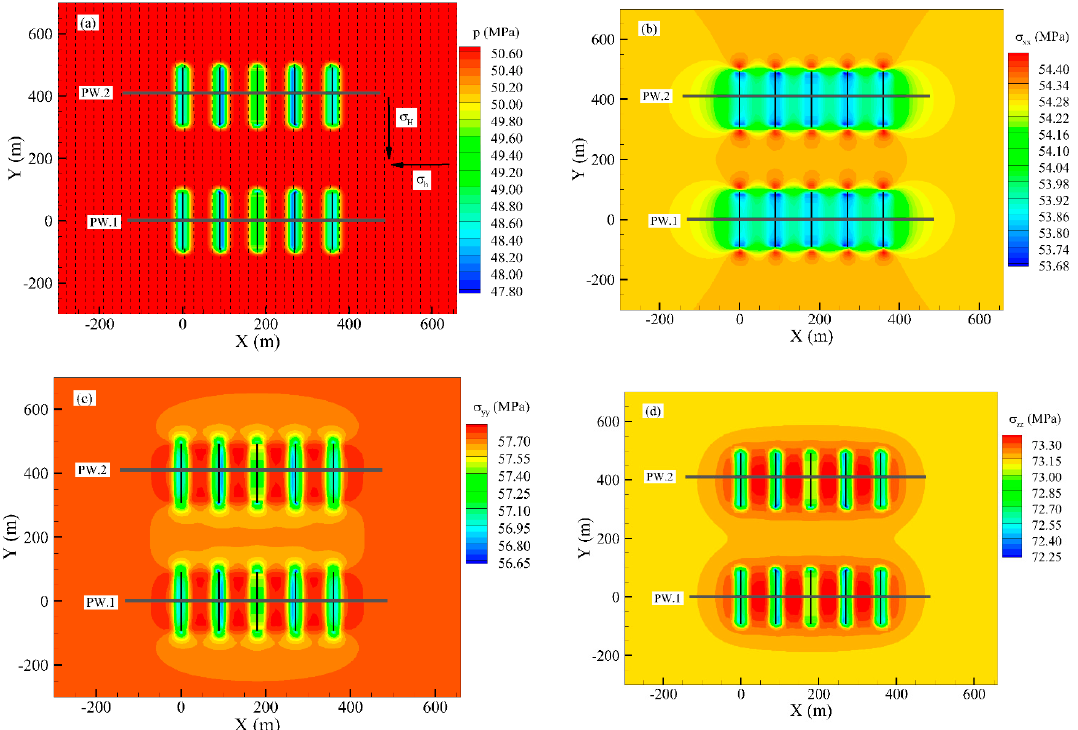
Figure 23. Reservoir pressure and stress state in a horizontal cross-section in the central XY-plane after repressurization of the production well fractures for 72 h at a constant bottomhole pressure of 45.0 (MPa): ( a ) pore pressure distribution; local principal stress trajectories are shown by dotted “black” lines, ( b ) horizontal stress component σ xx , ( c ) horizontal stress component σ yy , ( d ) vertical stress σ zz .